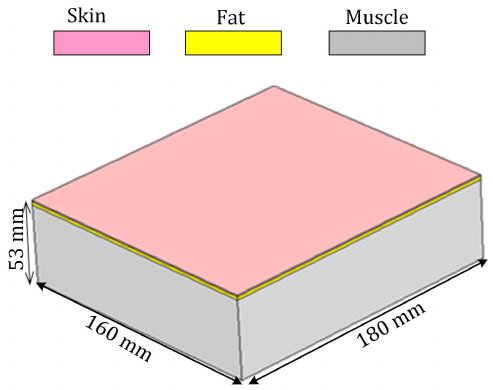
Figure 7. Overall flat body phantom used for modeling the typical human